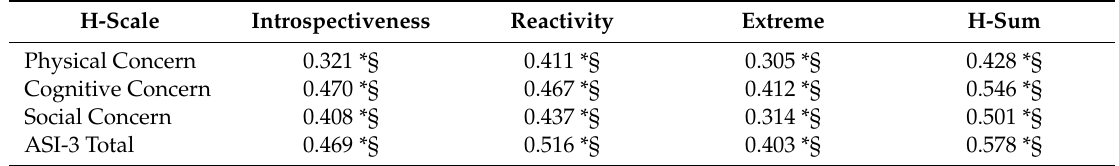
Table 2. H-Scale correlations with ASI-3.